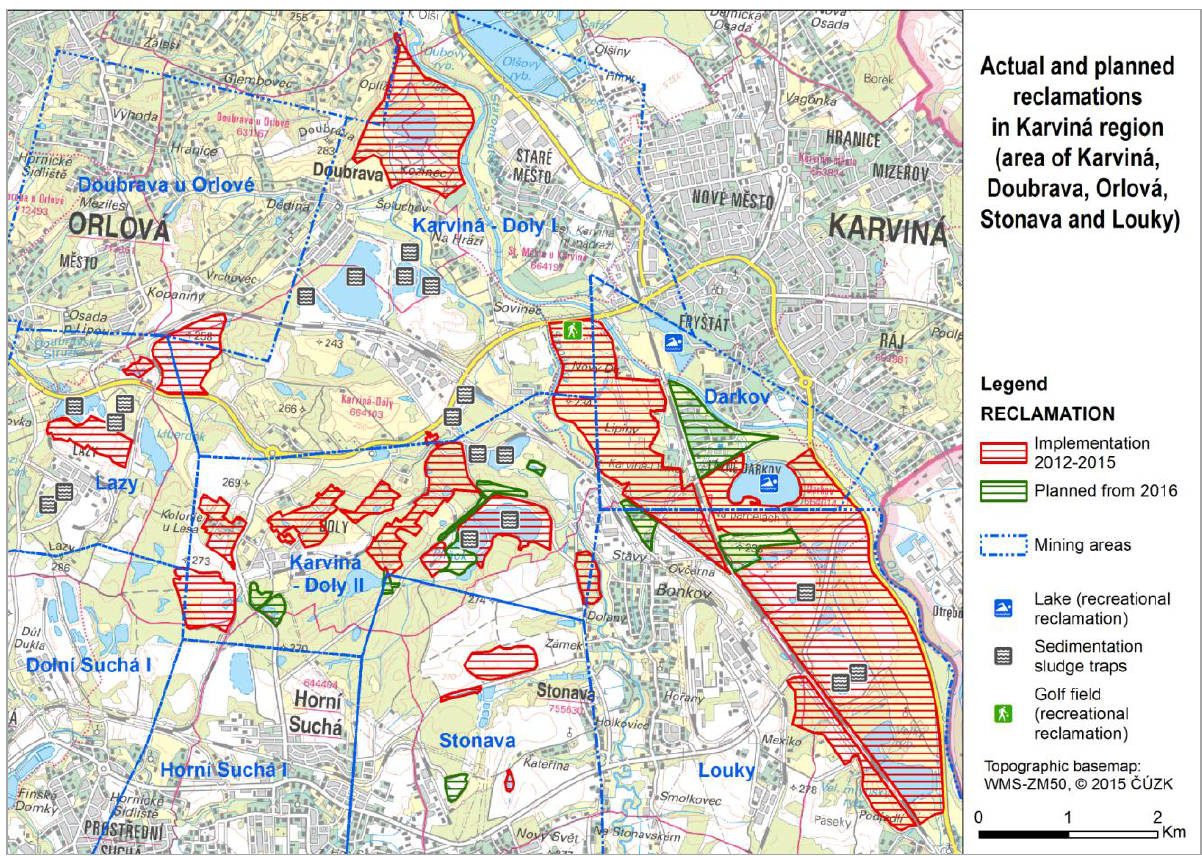
Fig. 3. Actual and planned reclamations in the Karviná